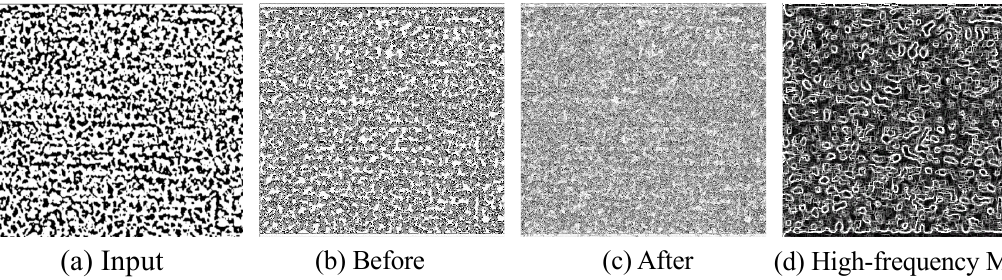
Figure 9. The visual feature maps and the high-frequency map. ( a ) Input image ( b ) The feature before the last downsampling layer ( c ) The feature after the last downsampling layer ( d ) High-frequency map.